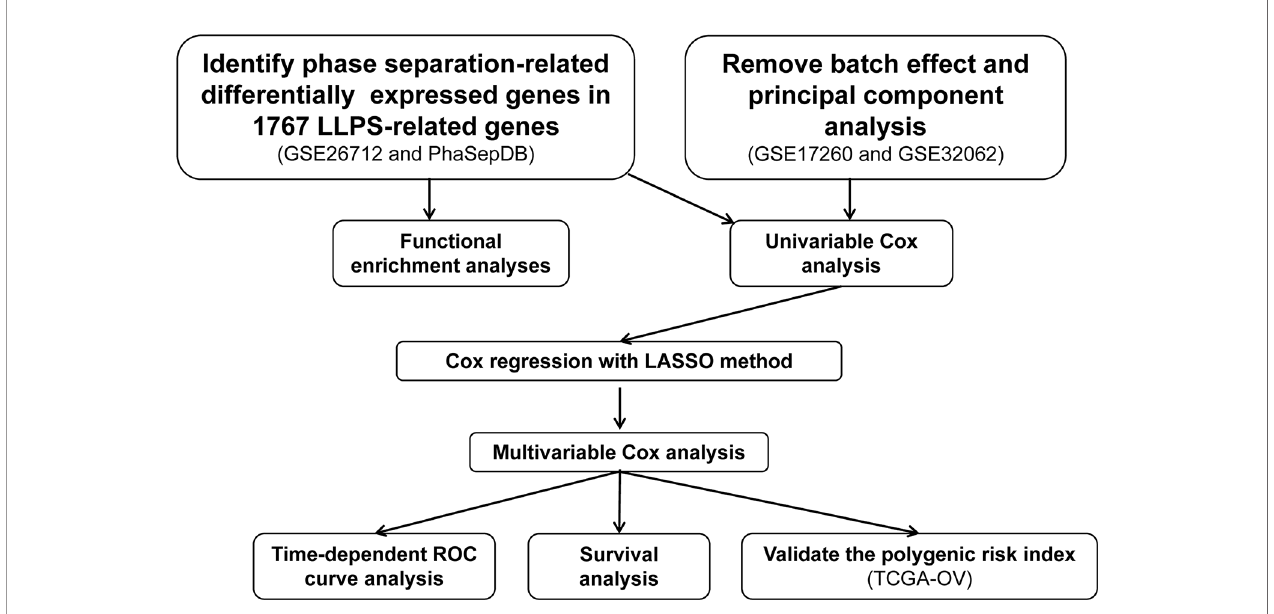
FIGURE 1 | The work fl ow of the present